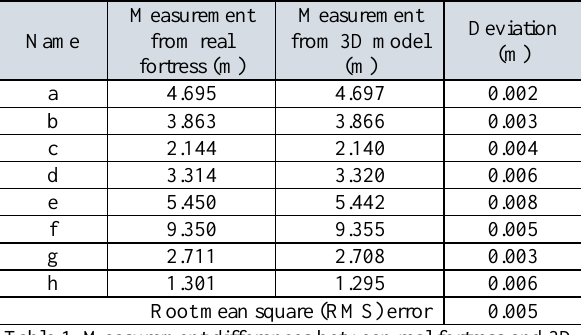
Table 1. Measurement differences between real fortress and 3D model